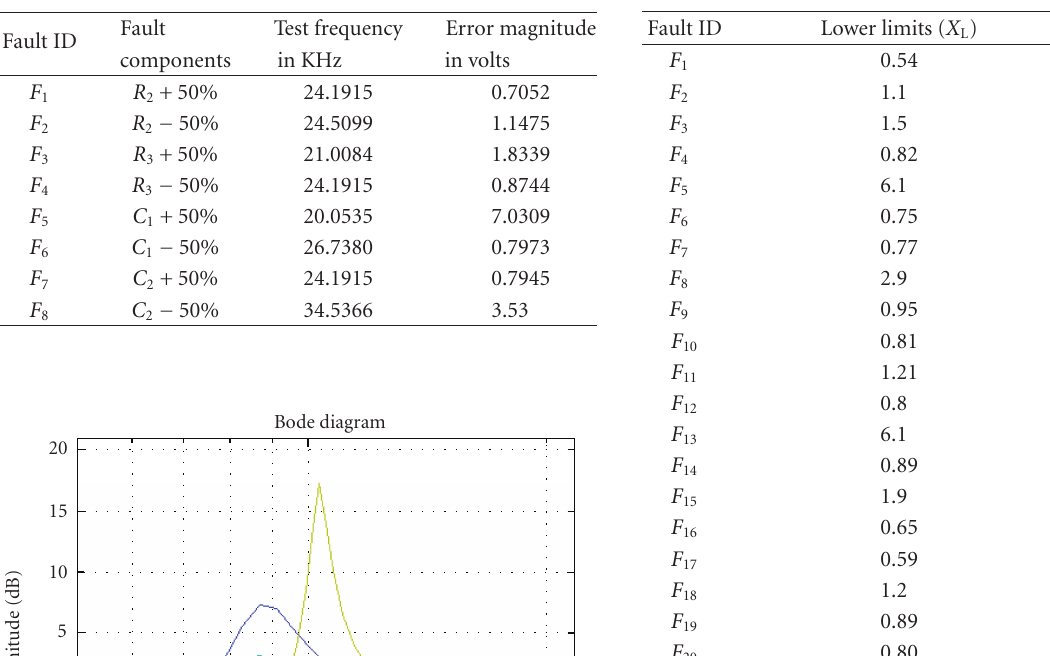
Table 1: Test frequencies of the single faults for test circuit.